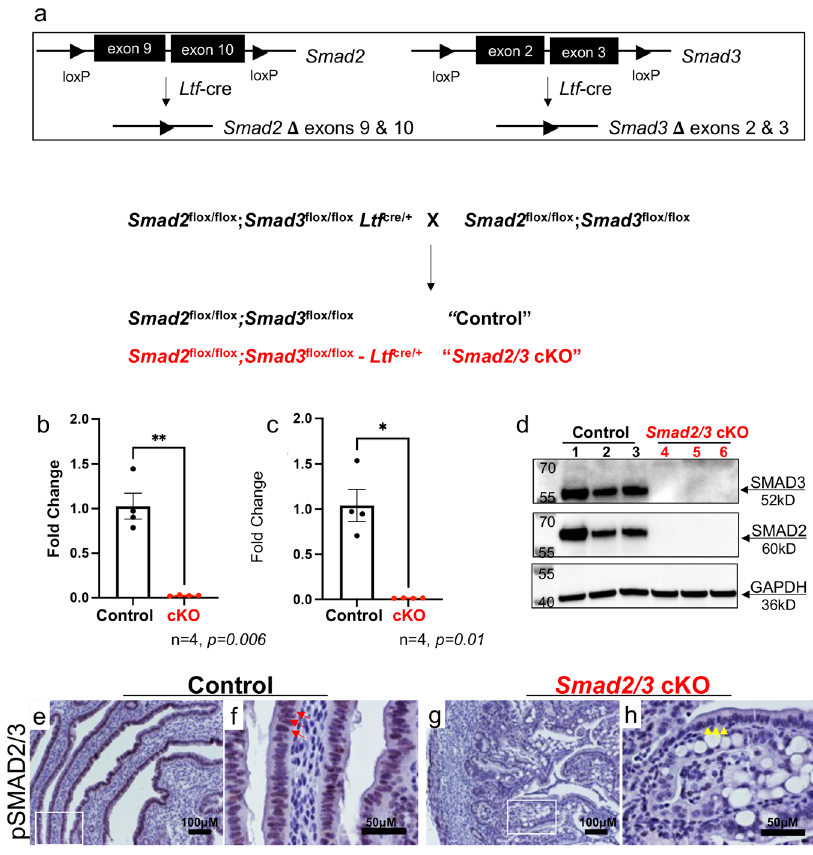
Fig. 1 Generation of mice with double conditional deletion of SMAD2 and SMAD3 using Ltf- cre. a Diagram showing the schematic used to obtain conditional deletion of SMAD2 and SMAD3 in the uterine epithelium using Ltf- cre. b – h Con fi rmation that effective deletion of the Smad2 and Smad3 fl oxed exons and protein levels were decreased in the uterine epithelium of Smad2/3 cKO mice at the mRNA level ( b , c , n = 4 per genotype) and in protein lysates from puri fi ed epithelium ( d , n = 3 per genotype). Lanes in ( d ) were generated from the same blot, which was sequentially probed and stripped with each of the indicated antibodies. e – h Immunohistochemical analysis of phosphorylated SMAD2 and SMAD3 (pSMAD2/3) in uterine cross-sections of control ( n = 3) and Smad2/3 cKO mice ( n = 3). Red arrows ( f ) show positively stained cells in uterine epithelial cells of controls, while yellow arrows ( h ) highlight the unstained epithelial cells in Smad2/3 cKO uterus. Histograms represent mean ± SEM analyzed by an unpaired two-tailed t